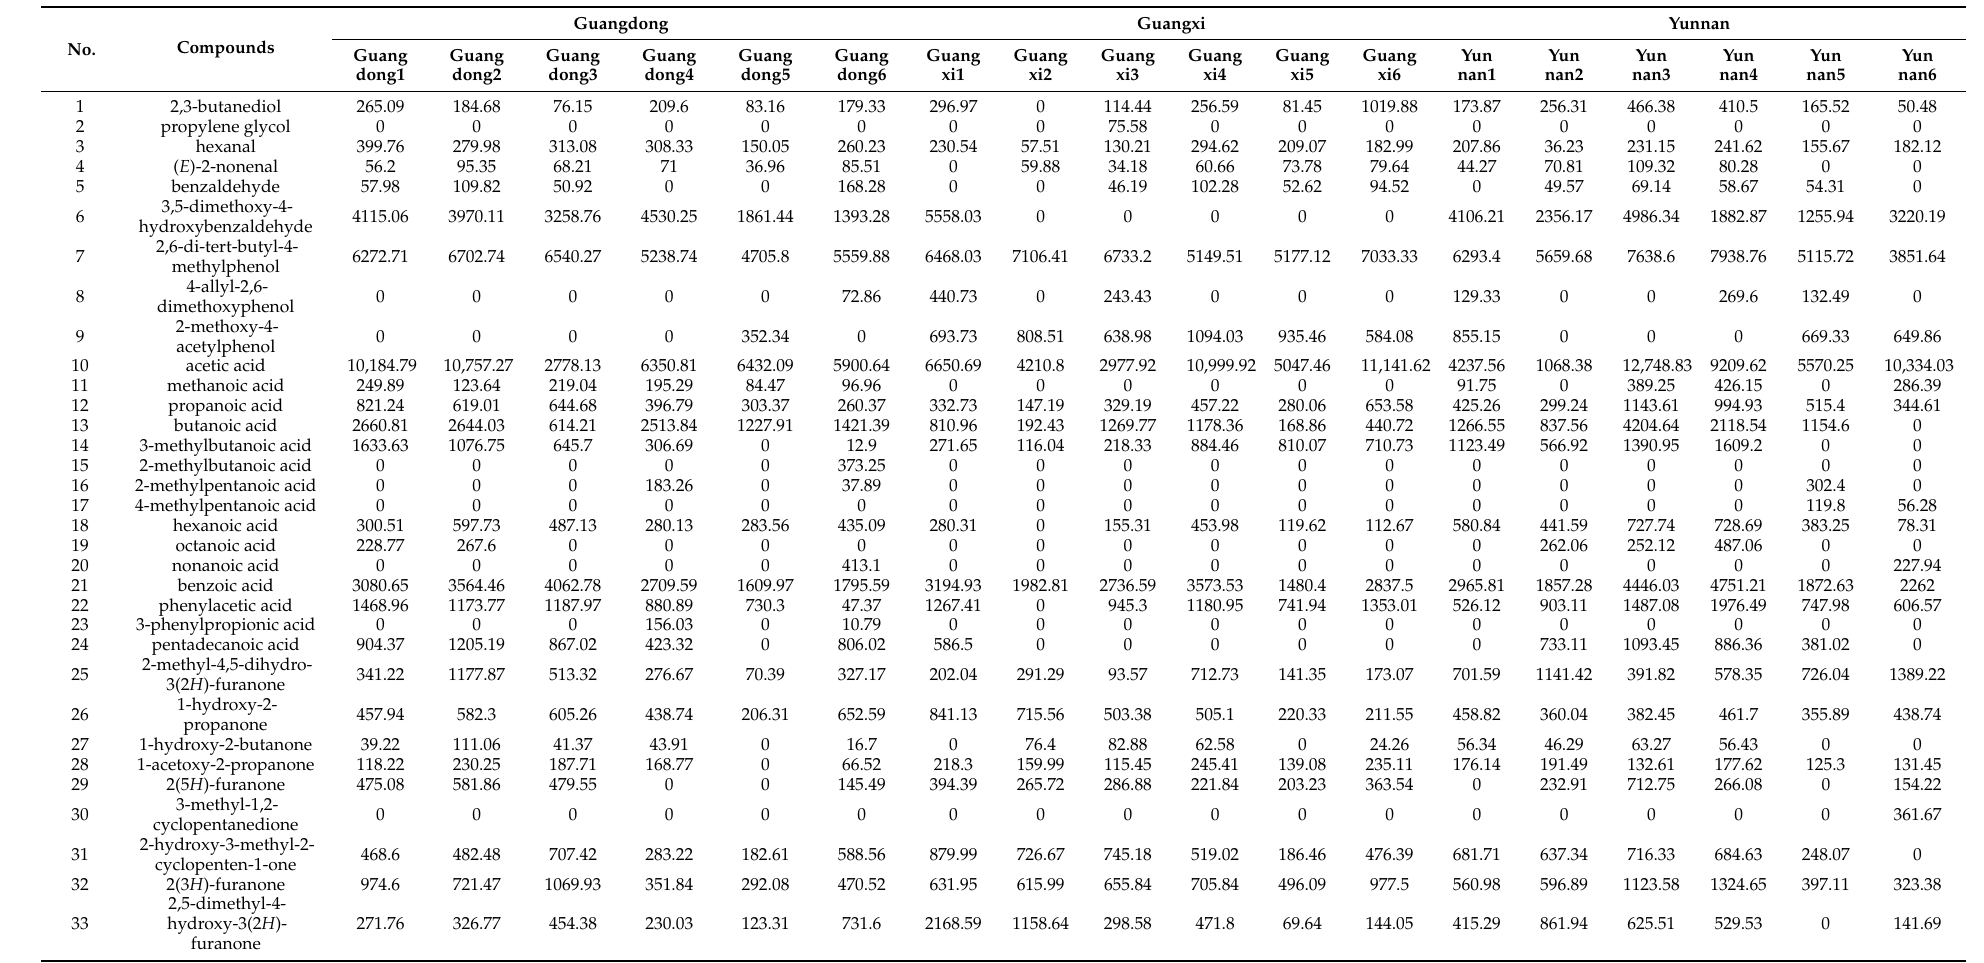
Table 3. Fingerprint results of brown sugar from each producing